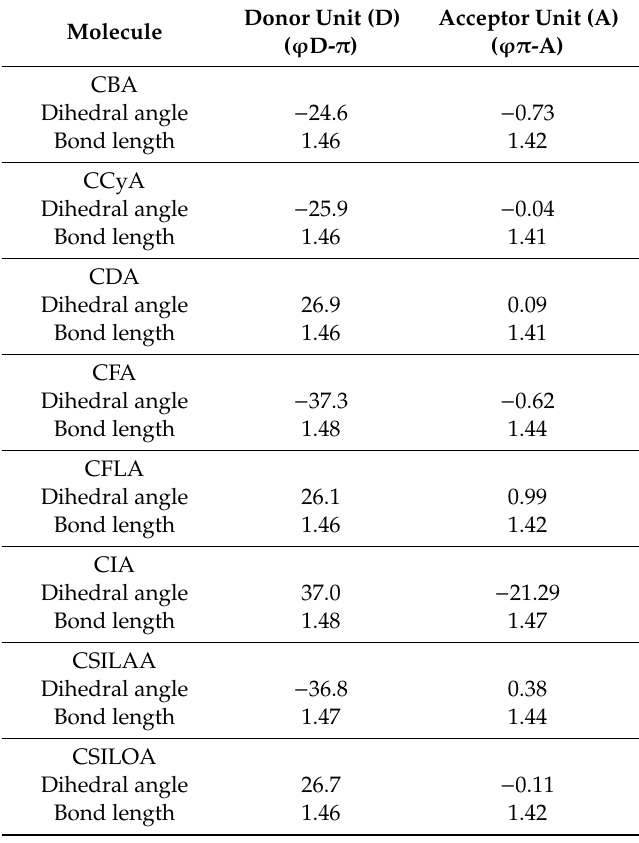
Table 1. Summary of bond lengths (in angstroms, Å) and dihedral angles (in degrees, ◦ ) between the donor unit, π -bright, and acceptor unit of the optimized structures with the M06 / 6-31G(d) level of calculation.